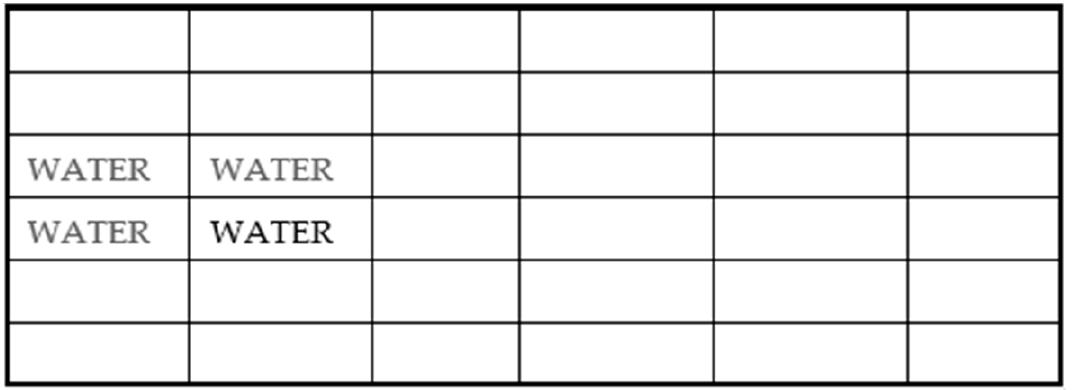
Figure 9. This is the difference WNM’ <B> of WNM’ <y> . minus tempmem <x> (Equation (90)).